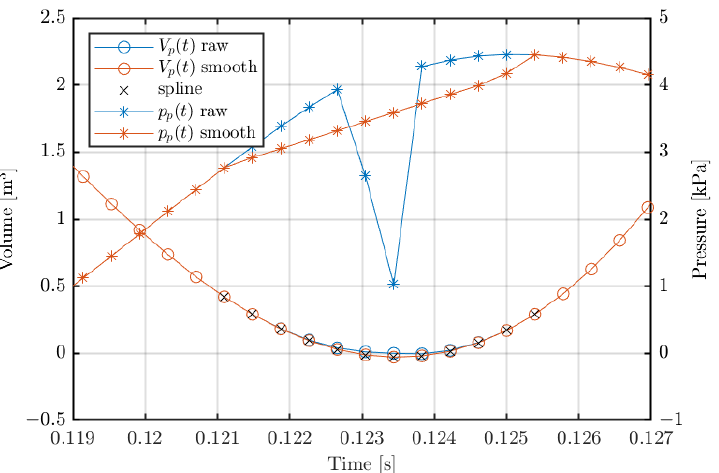
Figure 8. Exemplary sequence junction of the volume signal ( ◦ ) without (’raw’) and with smoothing by spline interpolation and the resultant pressure signal (*) showing the involved sampling points (x). No parameter variation is applied to the two